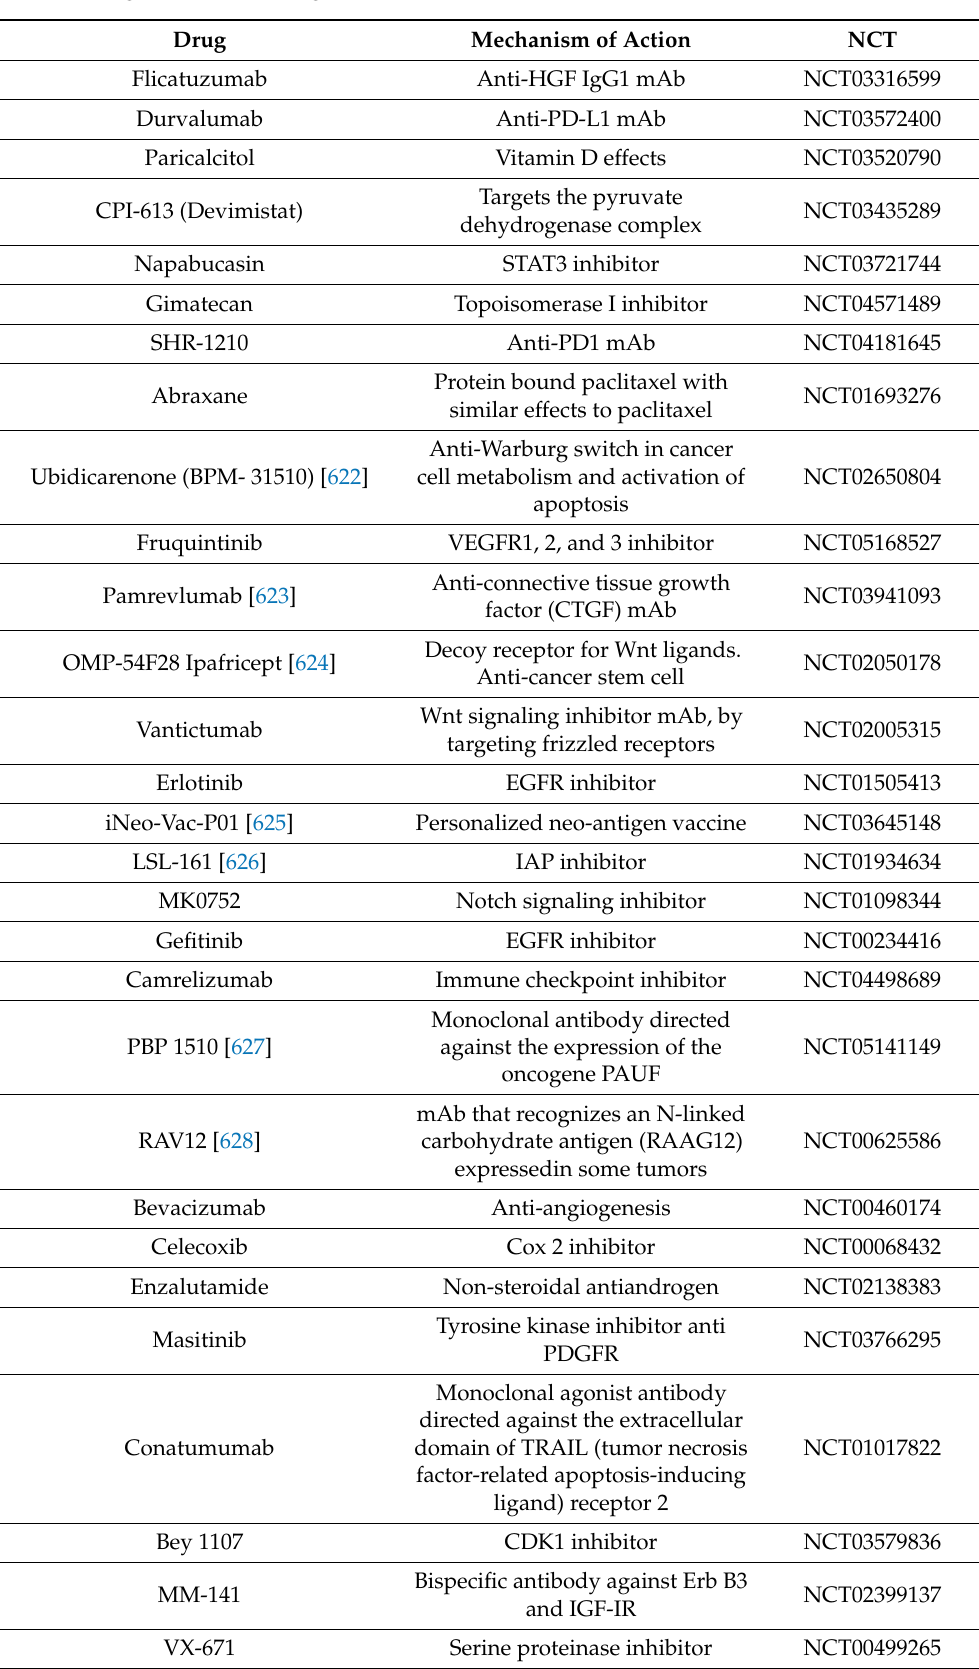
Table 3. Drugs associated with gemcitabine in clinical